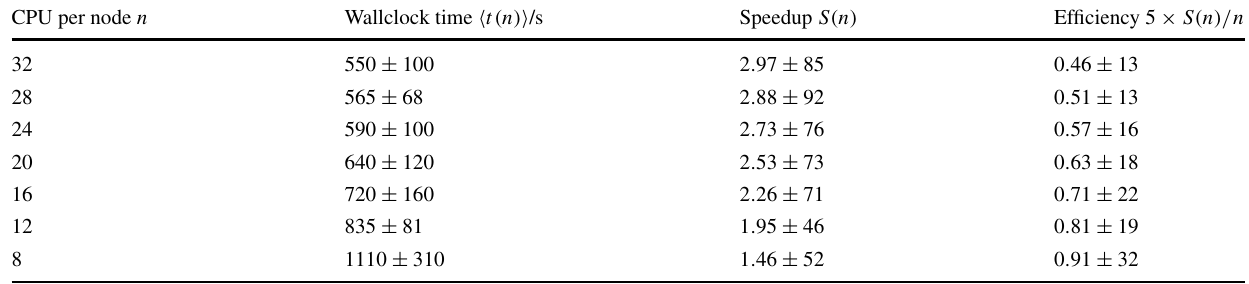
Table 1 Approximate benchmarks for parallel brackets. The spin- parity 1 + theory in (49) is augmented withall configurations of the mul- , ¯ β , ¯ β } – see (14) – and all the Poisson brackets tipliers {¯ α 3 , ¯ α 4 , ¯ α 6 , ¯ β 1 2 3 are obtained. Either four or five theories are allocated per node, wall-